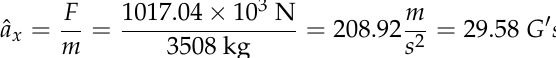
Figure 6. Displacement of the armored vehicle in the X -axis.